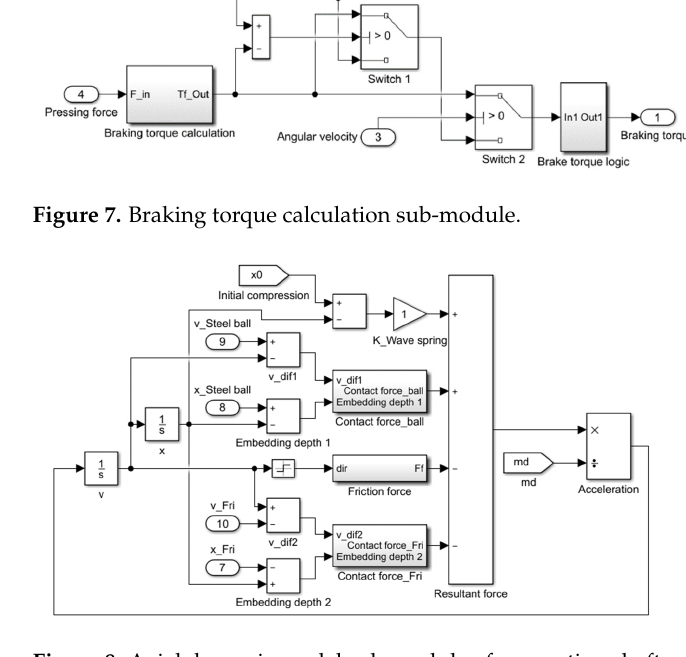
Figure 7. Braking torque calculation sub ‐ module.